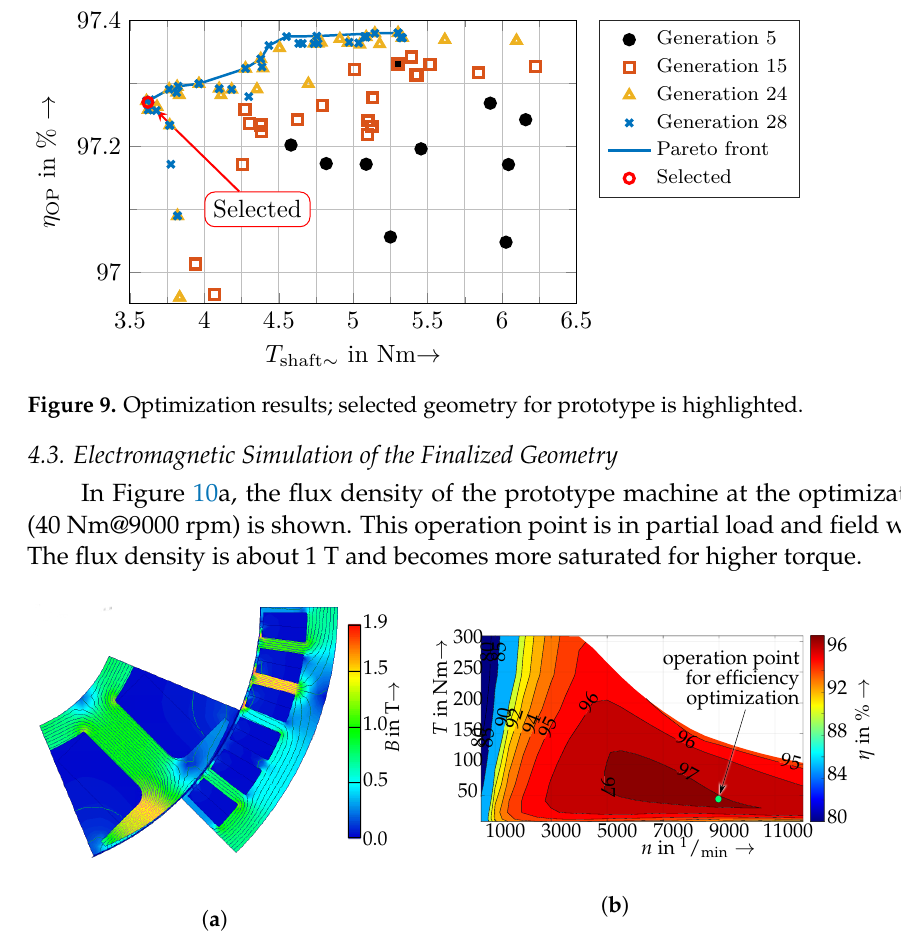
Figure 10. Simulation results of the optimized machine. ( a ) Flux density for prototype machine for 40 Nm@9000 rpm, ( b ) Simulated efficiency map for prototype machine considering copper and iron